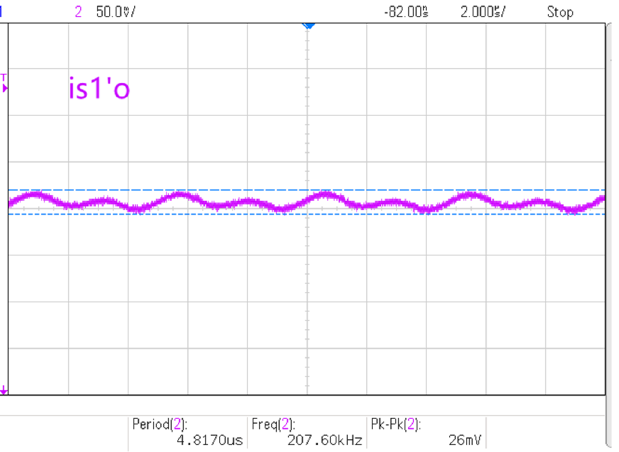
Figure 32. Waveform of 180° phase-shifting input current under load condition of IDC.